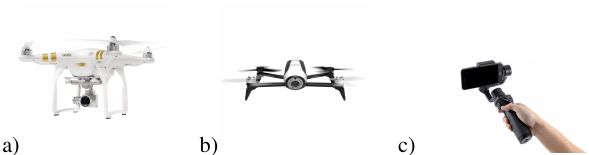
Figure 1. Camera stabilization can be done via a) mechanic gimbal or b) dynamic cropping from fish-eye camera, for drones or c) hand-held